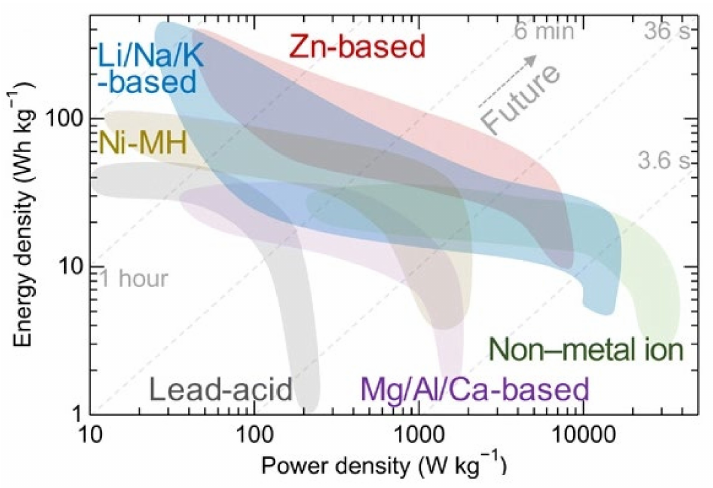
Figure 3. A comparative energy density curve for ZIBs and other energy storage systems. Reprinted with the permission from Ref. [45]. Copyright 2022 Science.